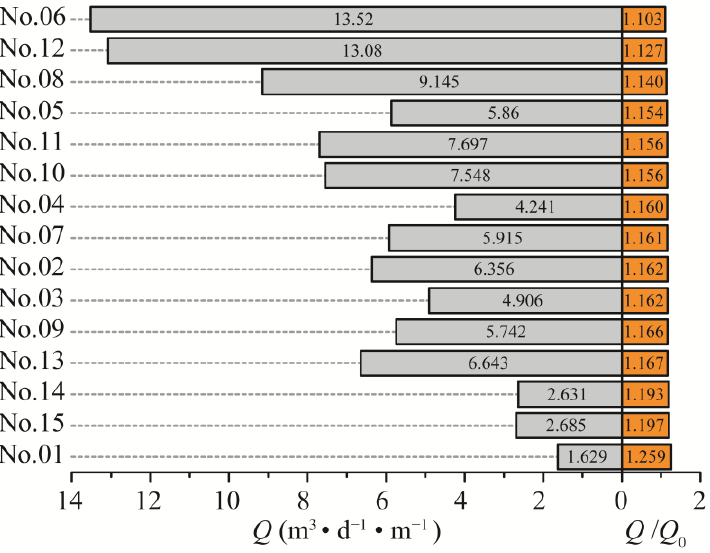
Figure 8. Q / Q 0 values with corresponding water inflow Q values in Qingdao Jiaozhou Bay Subsea Tunnel.